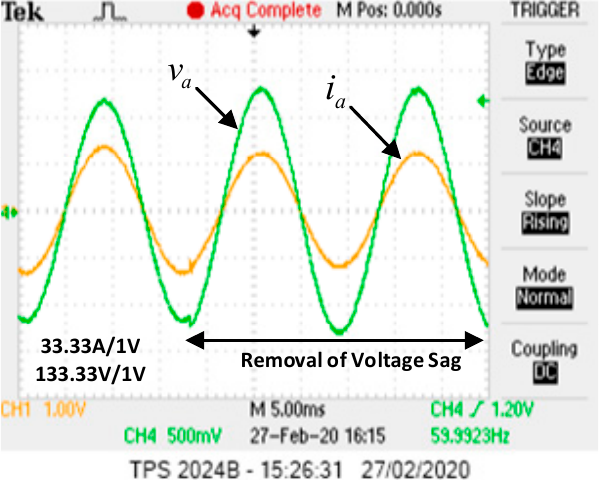
Figure 19. Voltage and current for phase A during an increase in the grid voltage from 108 Vrms to 120 Vrms. Pref = 10 kW and Qref = 0 kVAr.